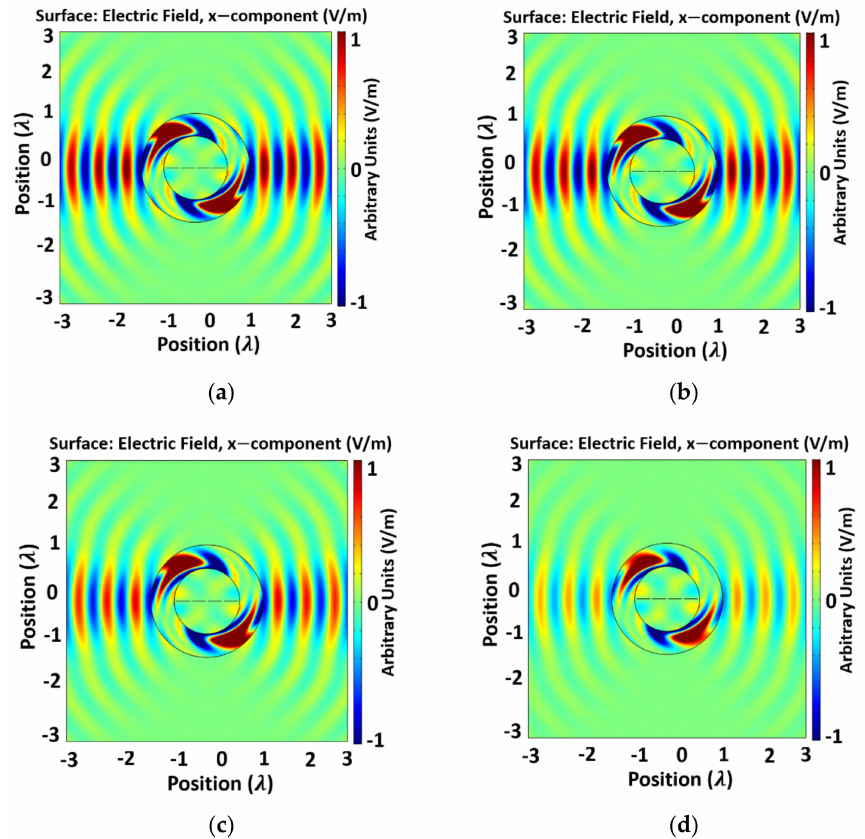
Figure 10. The electric fields for the proposed TO-based “horizontal array” for different values of loss factor (tan δ ): ( a ) tan δ = 0.0; ( b ) tan δ = 0.01; ( c ) tan δ = 0.1; ( d ) tan δ =